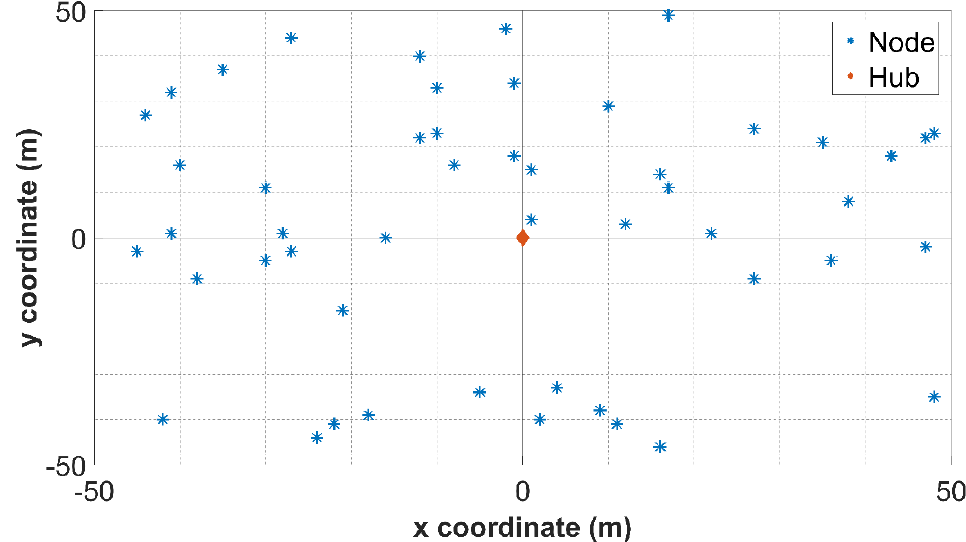
Figure 1. An example of centralized wireless sensor networks (WSNs) topology.